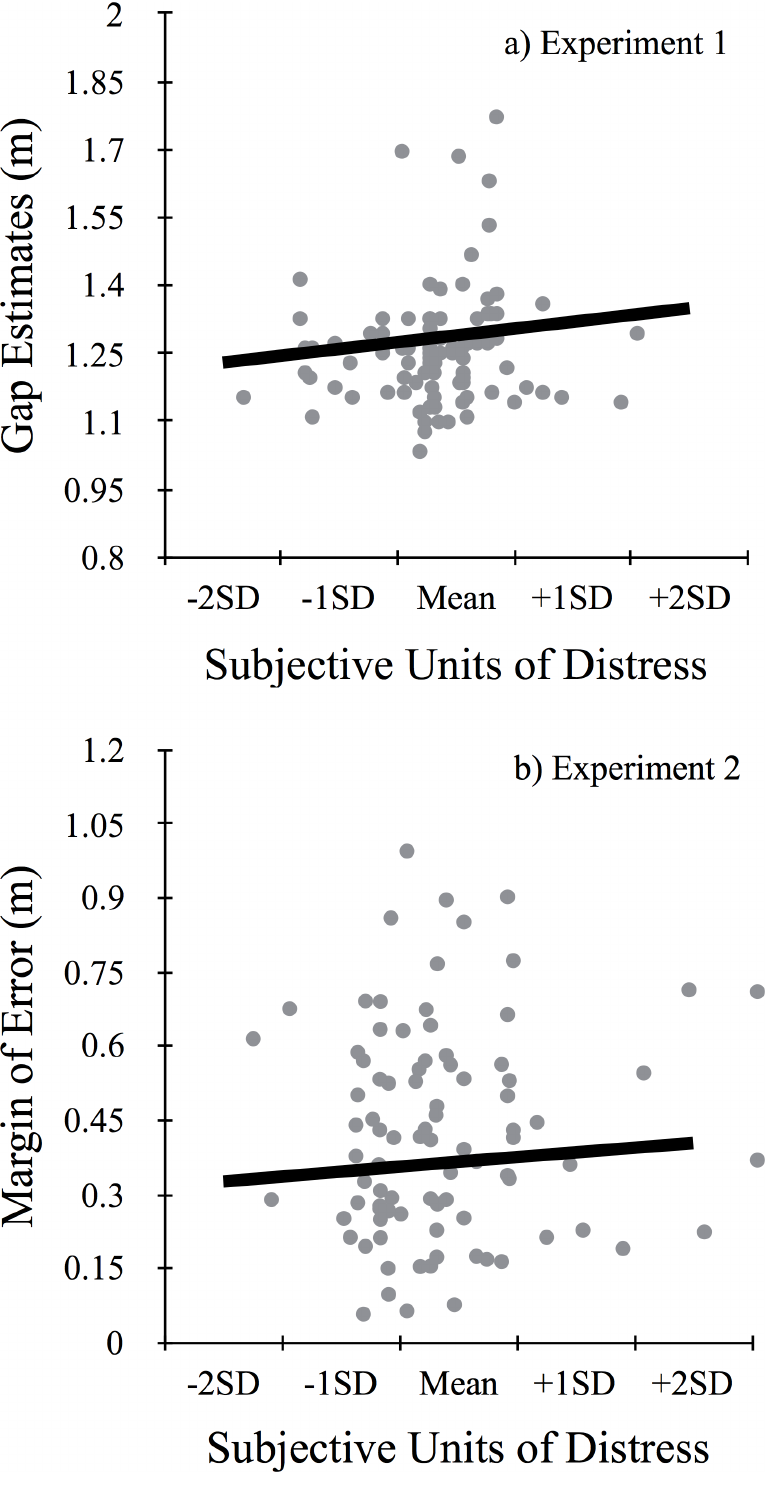
Fig 2. Estimates and Action as a Function of State Fear. (a) Estimates of gap width from Experiment 1 and (b) margin of error, or how far over the gap people stepped, from Experiment 2 are plotted as a function of state levels of fear (mean, +/1 SD) as measured by the Subjective Units of Distress Scale (SUDS). Both estimates of gap widths and margin of error increased with state fear and by a similar magnitude (5.3 and 3.9 cm,